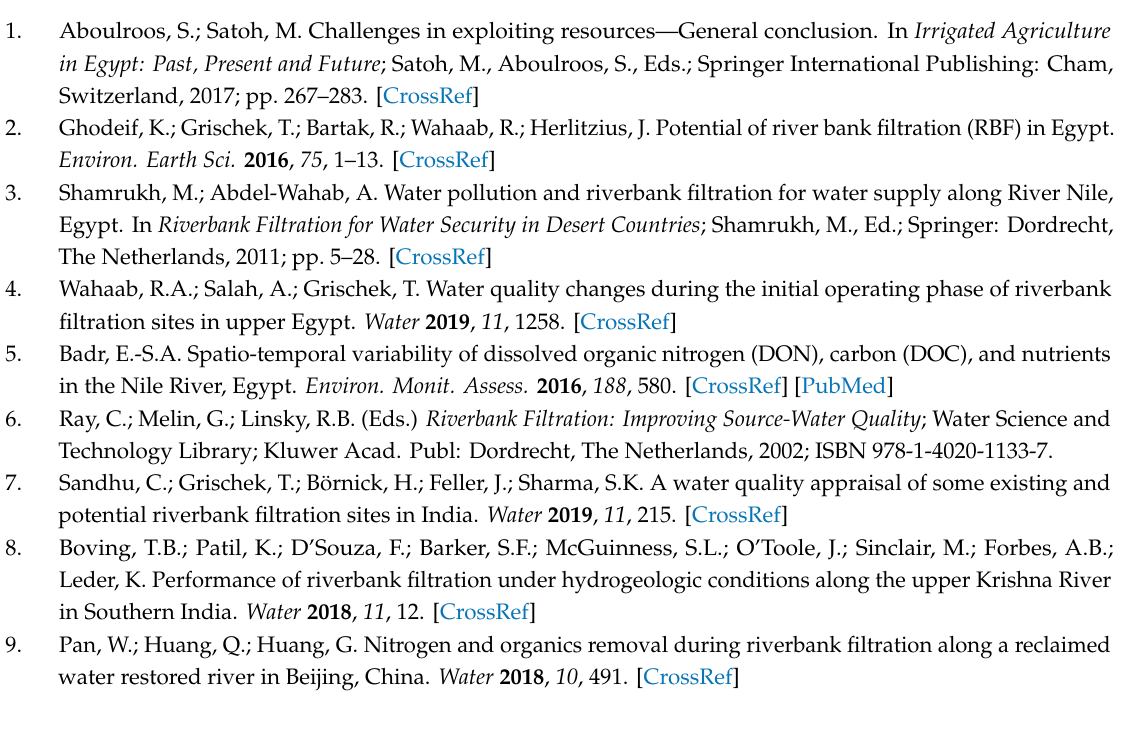
Figure S1: F-EEM spectra: (a) NR, (b) ADL, (c) BF1, (d) BF2, and (e) GW., Table S1: Physical and inorganic characteristics of the surface waters, bank filtrates and groundwater sources, Table S2: The concentrations of heavy metals in the surface waters, bank filtrates and groundwater sources, Table S3: Organic characteristics of the surface waters, bank filtrates and groundwater